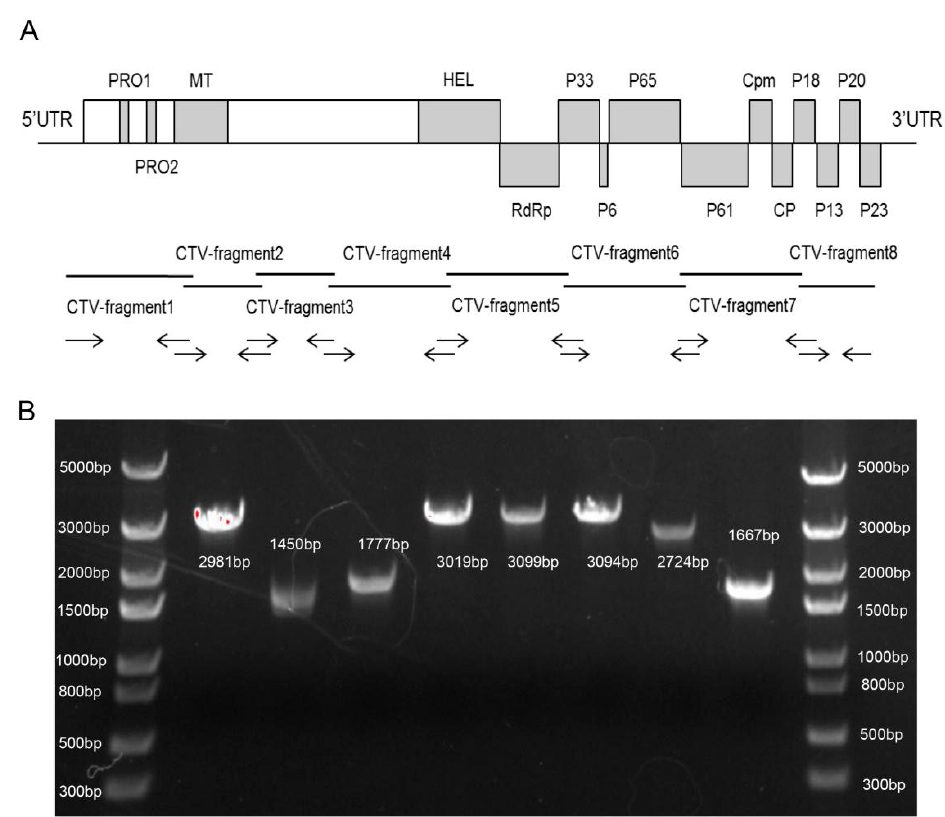
Figure 1. Citrus tristeza virus (CTV)-N4 cloning. ( A ) CTV genome organization and schematic representation of eight fragments amplified individually. ( B ) Product of each fragment cloned from CTV-N4. DNA bands from left to right are Trans5k DNA marker, successively purified CTV-N4 fragments 1 to 8, Trans5k DNA marker; and fragment length is indicated in the figure.